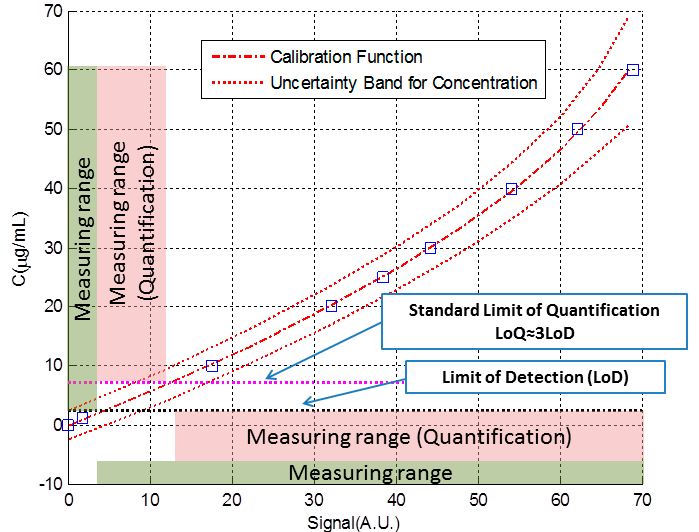
Figure 9. Data, calibration curve for parabolic fit, uncertainty band, limits of detection and quantification and measuring intervals for the given example.